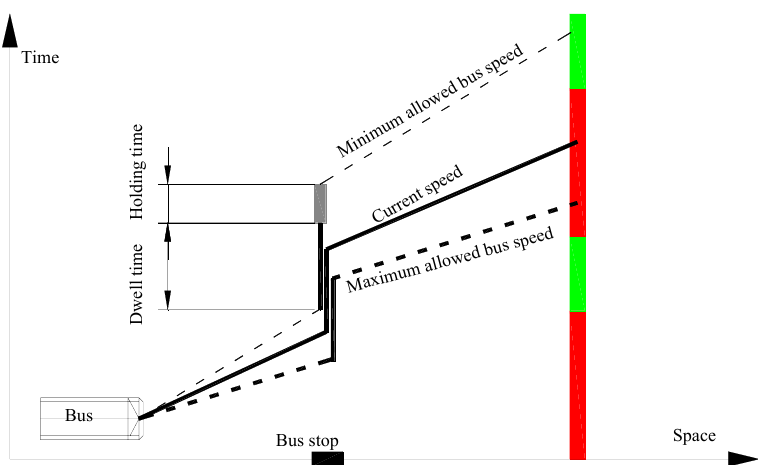
Figure 1. Interaction of bus speed and bus holding